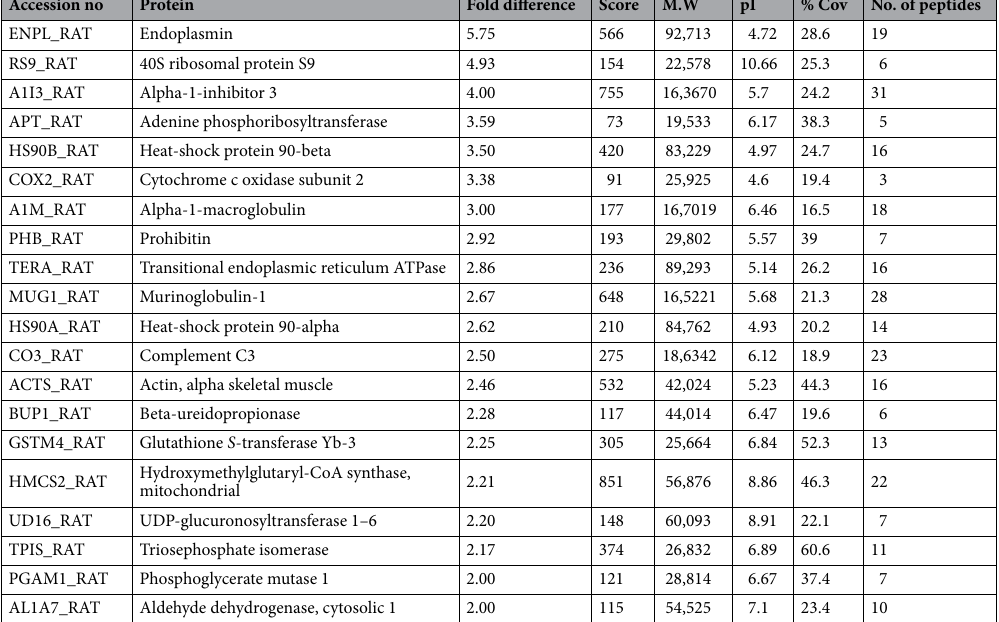
Table 1. Top-20 most upregulated hepatic proteins in the HFLac group vs. the HF group.